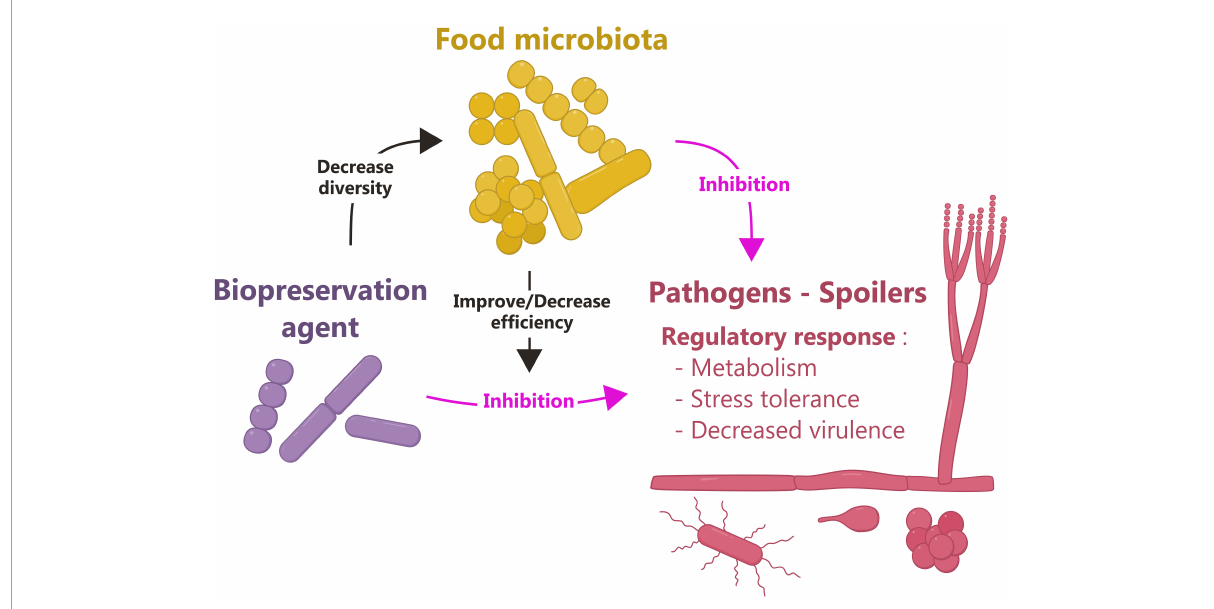
FIGURE1 Major advances in the field of biopreservation thanks to omics approaches. The objective of biopreservation is to induce growth cessation or decay of pathogens and spoilers. Omics approaches have shown that in response to biopreservation, target microorganisms modulate the expression of genes involved in cell metabolism, stress tolerance and virulence. In addition, omics revealed that biopreservation can decrease the diversity of food microbiota. Conversely, depending on its structure, the food microbiota can either improve or reduce the effectiveness of biopreservation agents. Food microbiota can also have intrinsic protective properties and thus inhibit unwanted